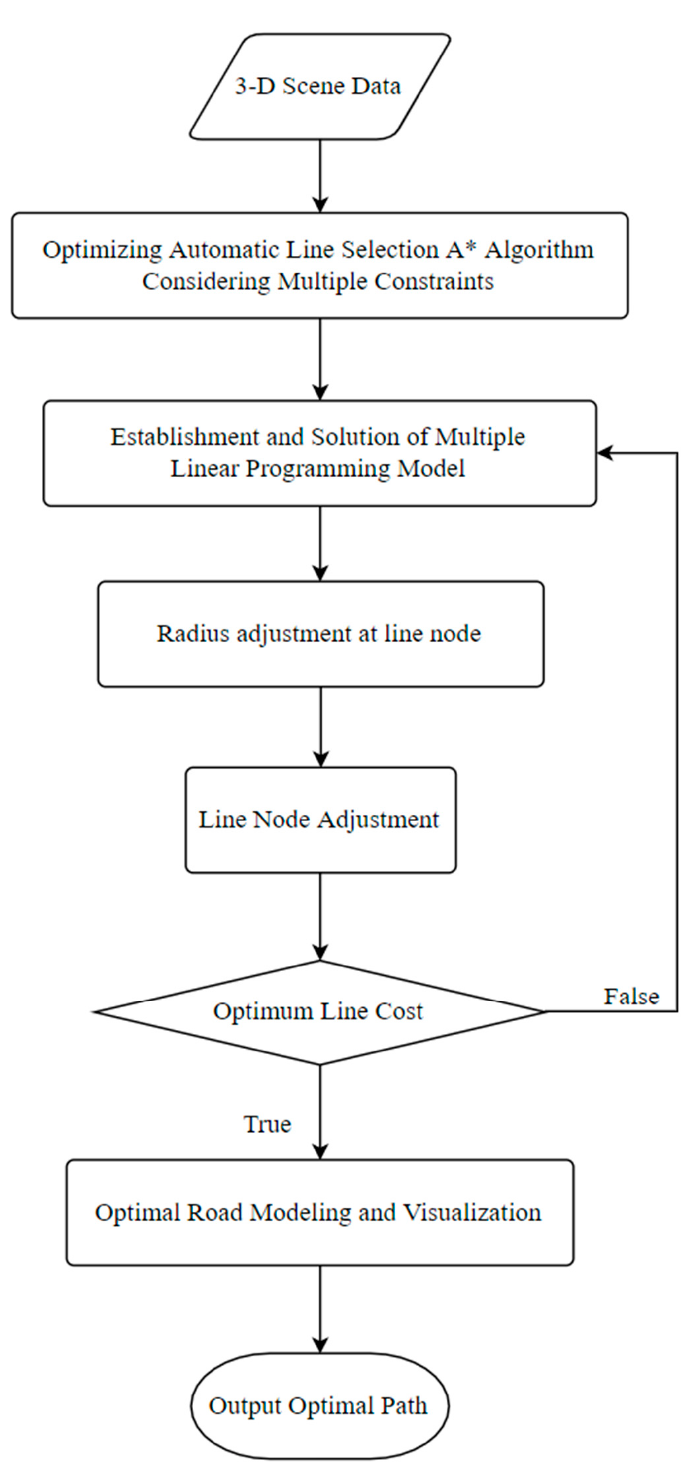
Figure 5. LP model’s algorithm fl ow.